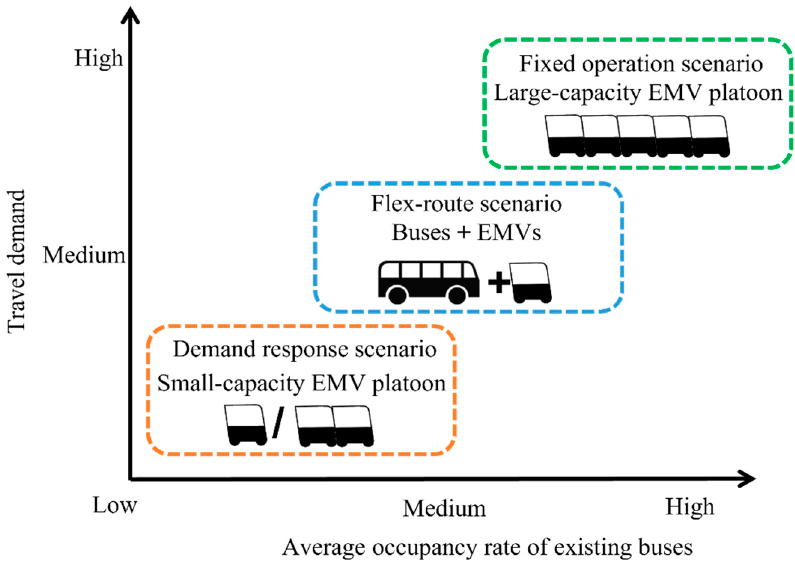
Figure 5. Three application scenarios with varying travel demands and average occupancy of existing buses.